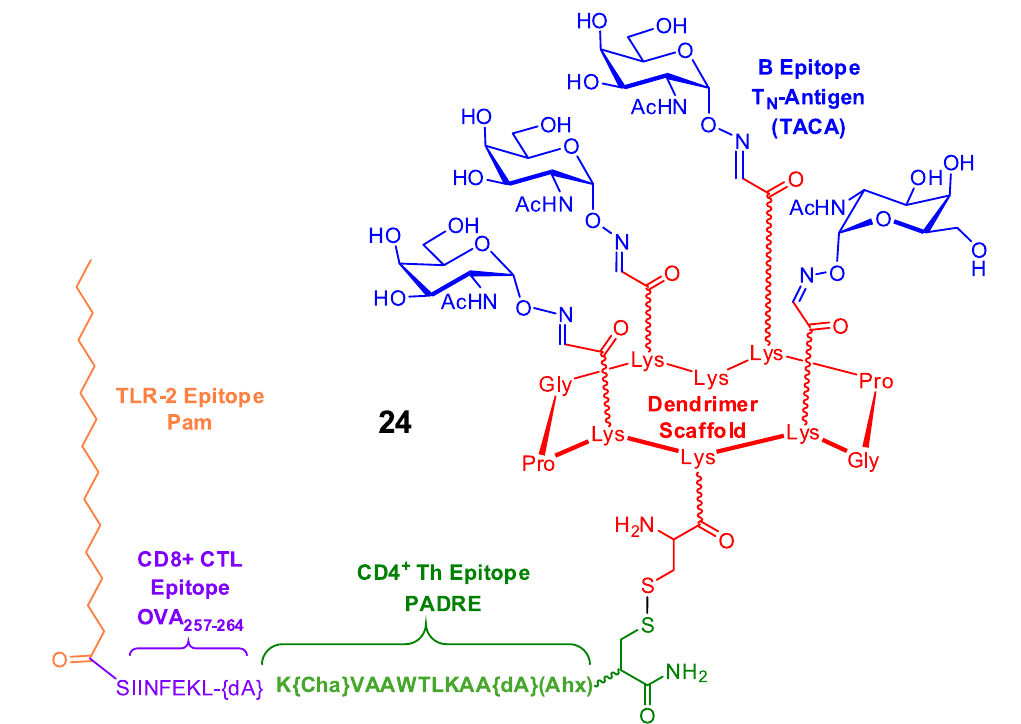
FIGURE 10 - Multicomponent TACA vaccine incorporating of the requisite elements to raise both humoral and cytotoxic immunity (Galan, Dumy, Renaudet,